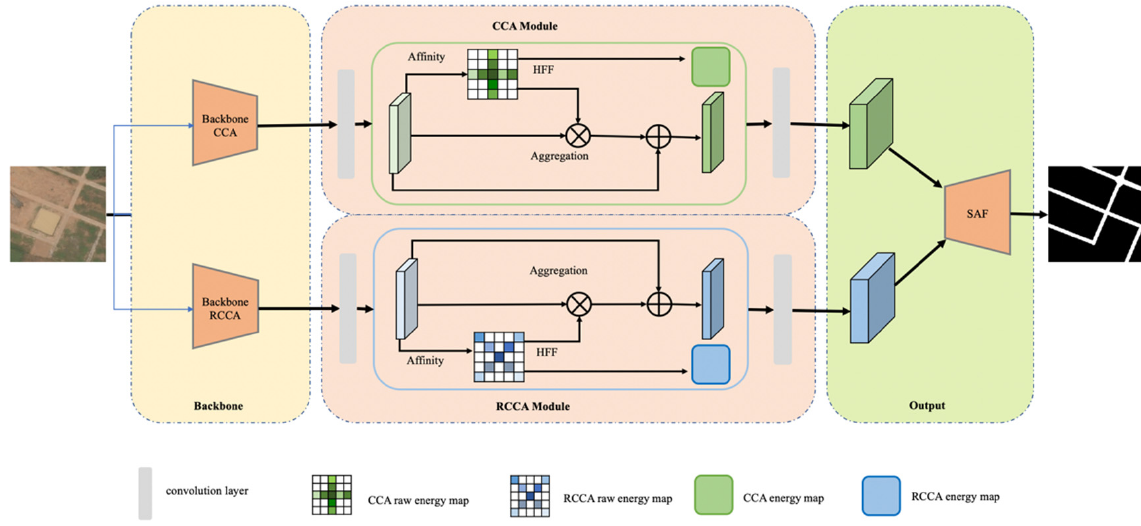
Figure 2. Network Structure.